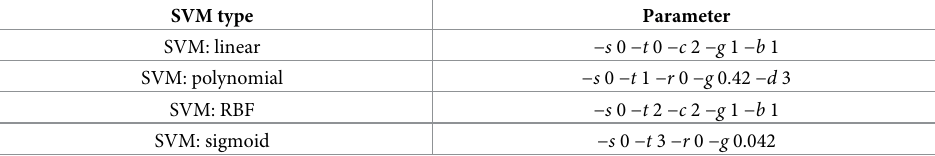
Table 12. The parameters of four SVM classifiers for EMDS-5 image classification (supported by LIBSVM).